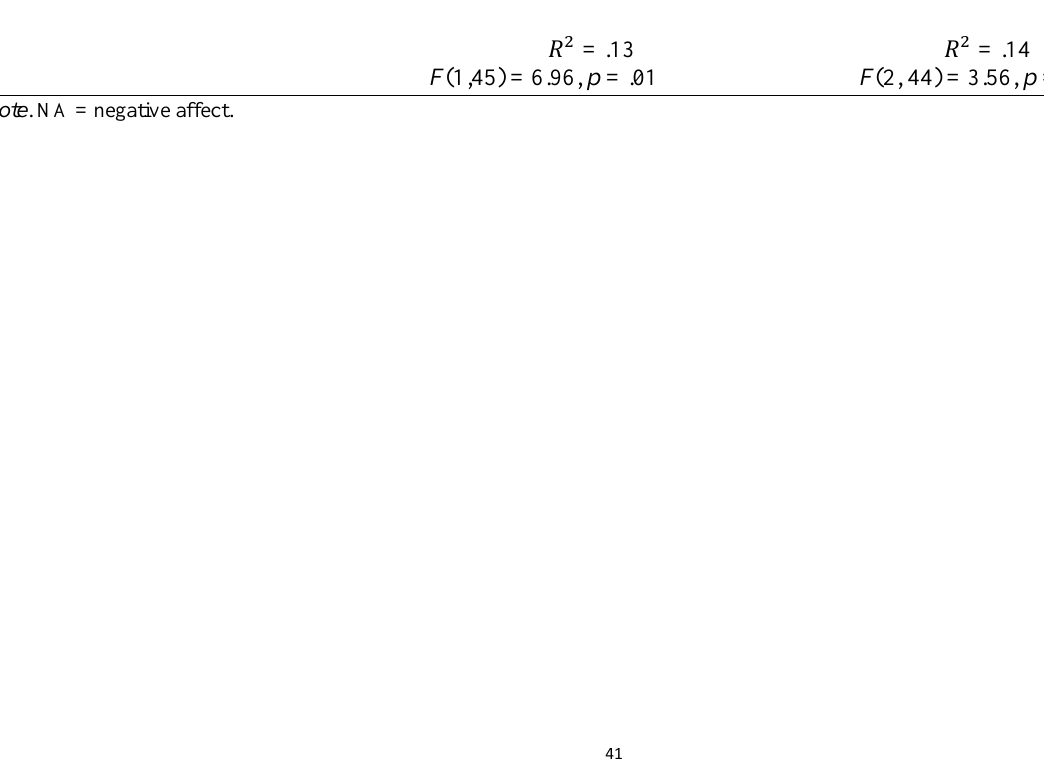
Mediation Model for NA on Exam Day Outcome M (Time Management Failures) Y (NA on Exam Day) Predictor Coeff. SE p Coeff. SE p X (Emo. Regulation.